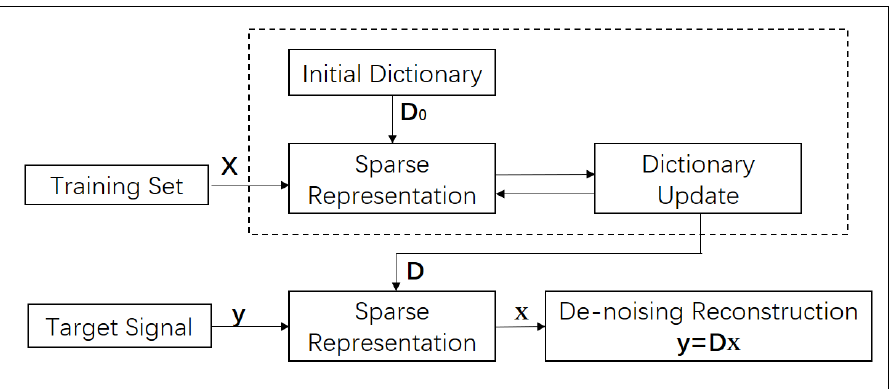
Figure 5. Flow chart of denoising procedure by dictionary learning. The dashed line box contains the dictionary learning procedure, where an initial dictionary for the training set is